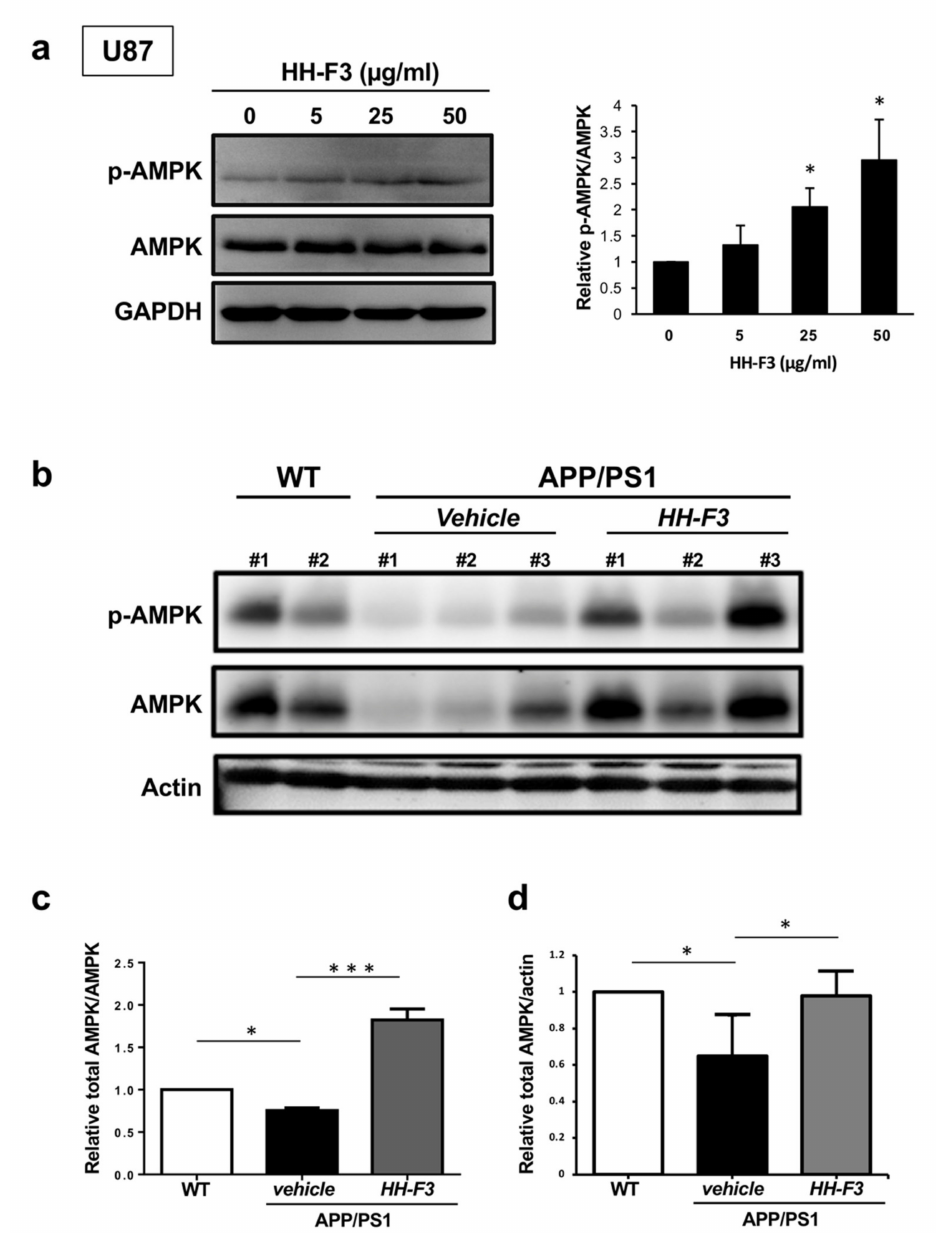
Figure 3. GP extract HH-F3 enhanced AMPK activity in U87 cells and APP/PS mice. ( a ) Western blot analysis of AMPK phosphorylation (Thr172) and AMPK in U87 cells treated with 0, 5, 25, and 50 µ g/mL of HH-F3 for 24 h. Mean ±